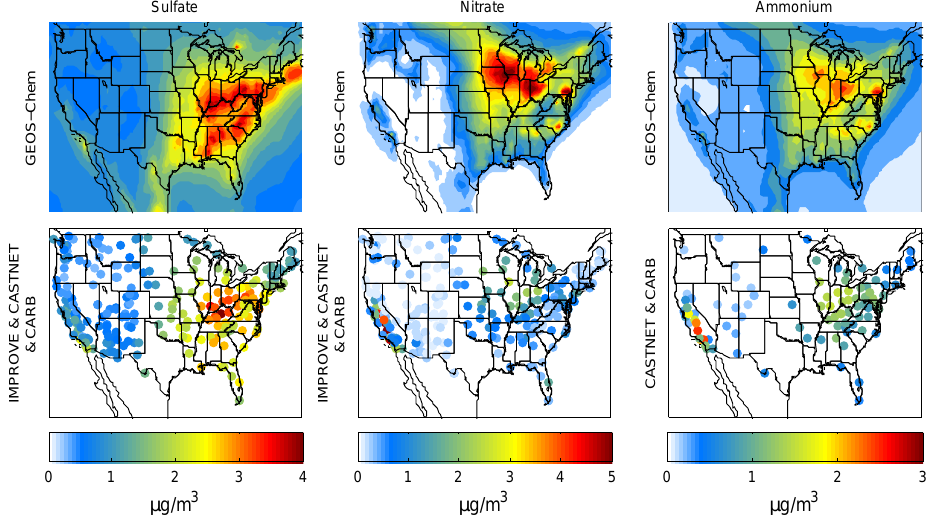
Fig. 4. Predicted 2009 annual mean aerosol concentrations compared with measured concentrations.